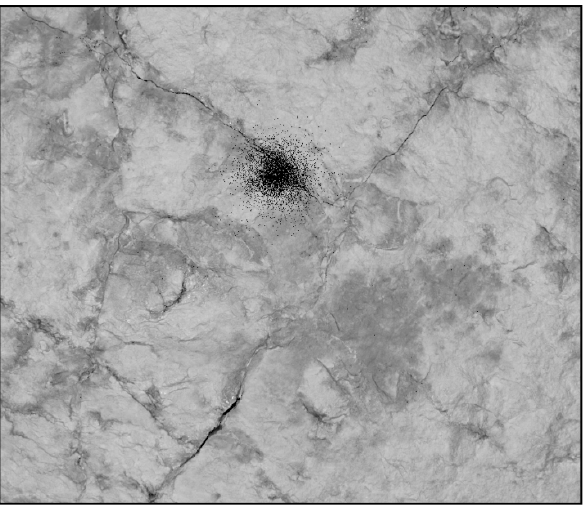
Figure 11. Orthophoto of the cave dome (looking upward from inside): cracks on the